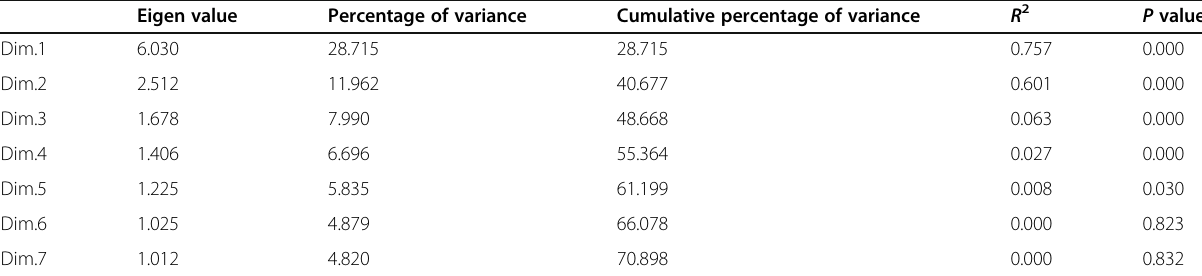
Table 1 Principal components obtained with FAMD and their link with the clustering analysis Eigen value Percentage of variance Cumulative percentage of variance